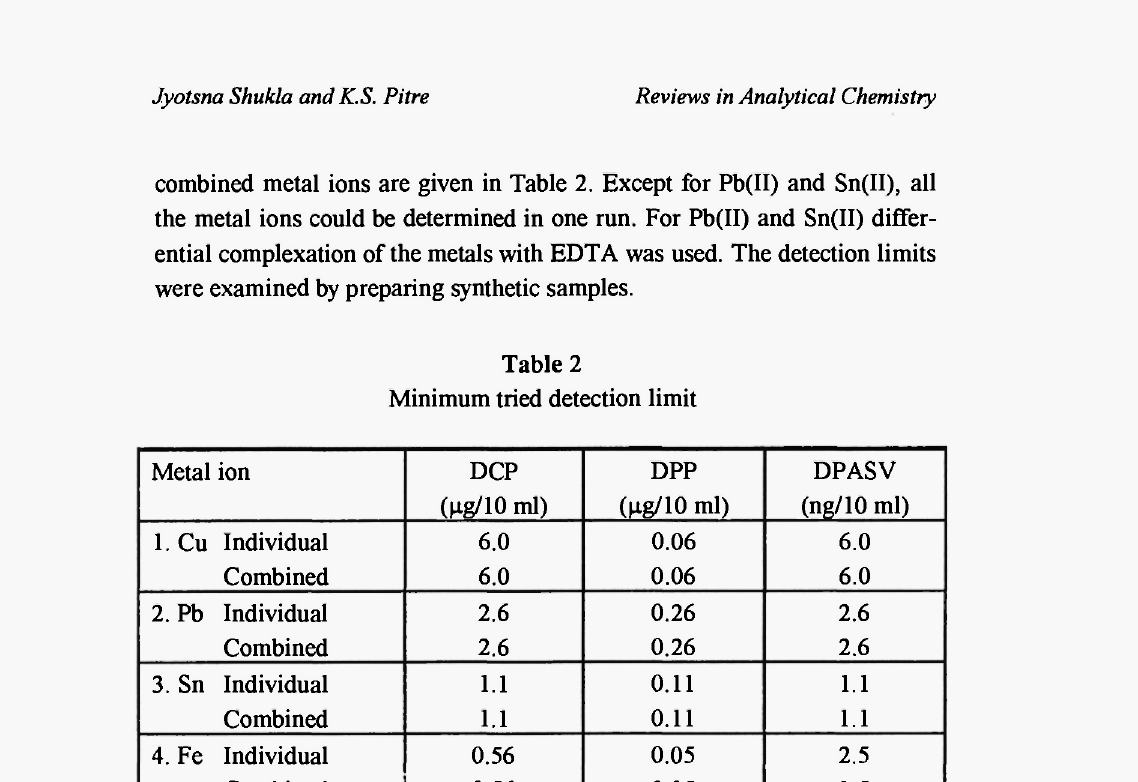
Final analysis results for metal contents of different milk